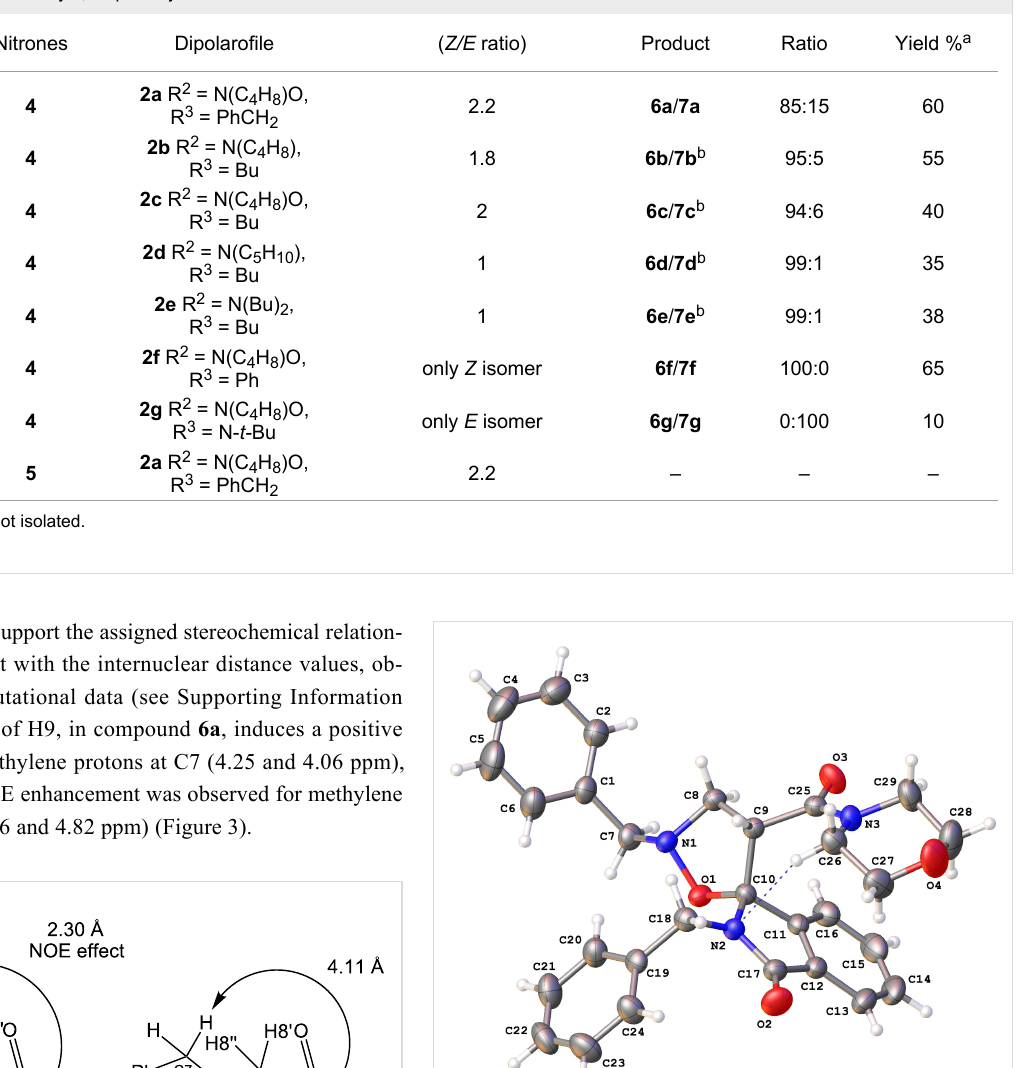
Table 1: Synthesis of 6a–f by 1,3-dipolar cycloaddition.